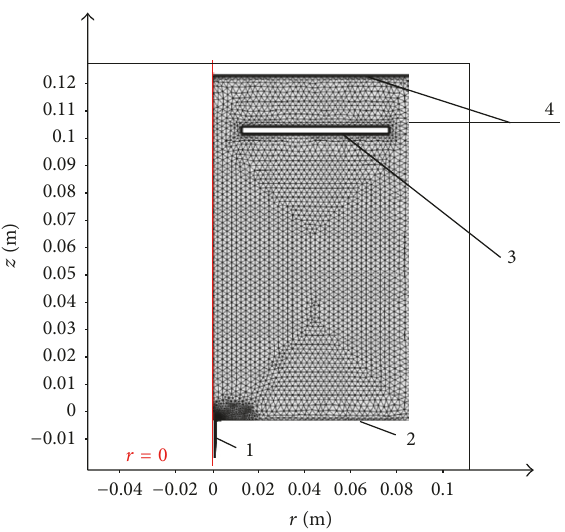
Figure 1: Geometry of the computational zone: 1: vapor channel; 2: surface of the sample being welded; 3: electron collector; 4: edges of the calculation